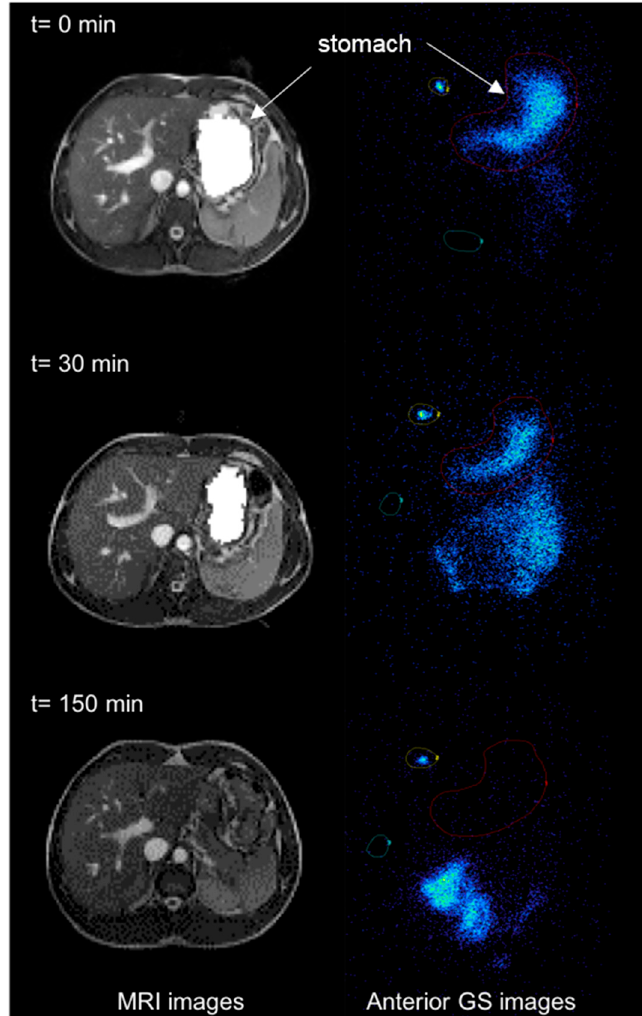
Figure 1. Example of magnetic resonance imaging (MRI) and Gamma scintigraphy (GS) images of the stomach at different time points after a participant ate the soup test meal (t = 0 immediately after feeding, t = 30 min after feeding and t = 150 min at the end of the study period). The axial, moderately T2 weighted images are shown on the left hand of the panel and the coronal planar gamma scintigraphy images are shown on the right hand of the panel, with labels and arrows to indicate anatomical landmarks. Regions of interests (ROIs) were defined around the labelled meal in the stomach (red), around an area of background activity (green) and around the radioactive marker (yellow).